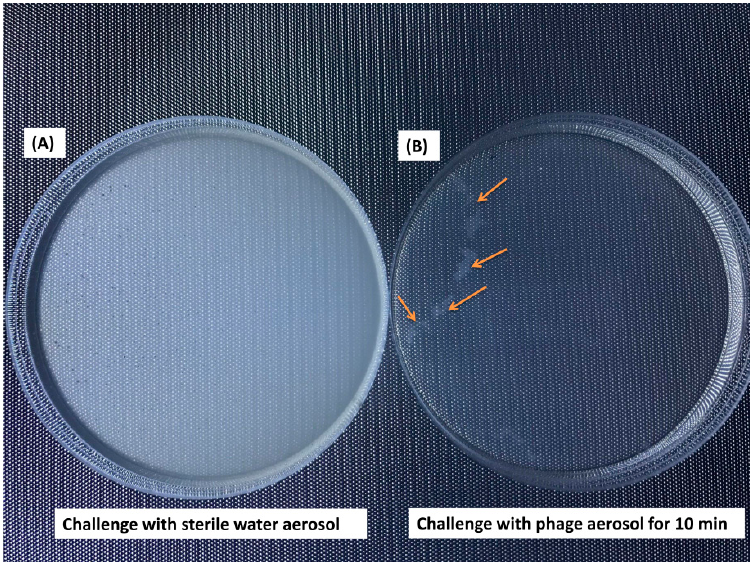
Figure 5. Phage aerosols deposited on plate surfaces with growing lawns of the bacterial host (OD 600 = 0.6). ( A ) Host bacterial lawn without phage aerosol challenge (sterile water aerosol) and ( B ) host bacterial lawn exposed to phage aerosol (10 8 PFU/m 3 ) for 10 min. Arrows indicate a few areas of host lawn that were not covered by the phage aerosol and still maintained a translucent appearance. Host bacterial lawns exposed to phage aerosol for longer than 10 min demonstrated complete clearance.